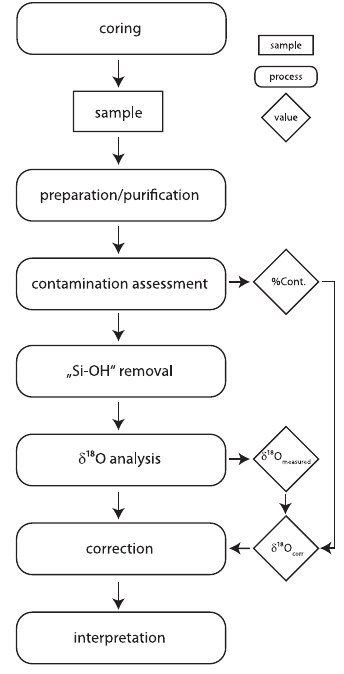
Fig. 2. Method outline from coring to final